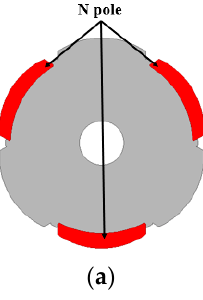
Figure 4. Intersect magnet consequent pole model: ( a ) N pole consequent pole, ( b ) S pole consequent pole, ( c ) intersect magnet consequent pole.